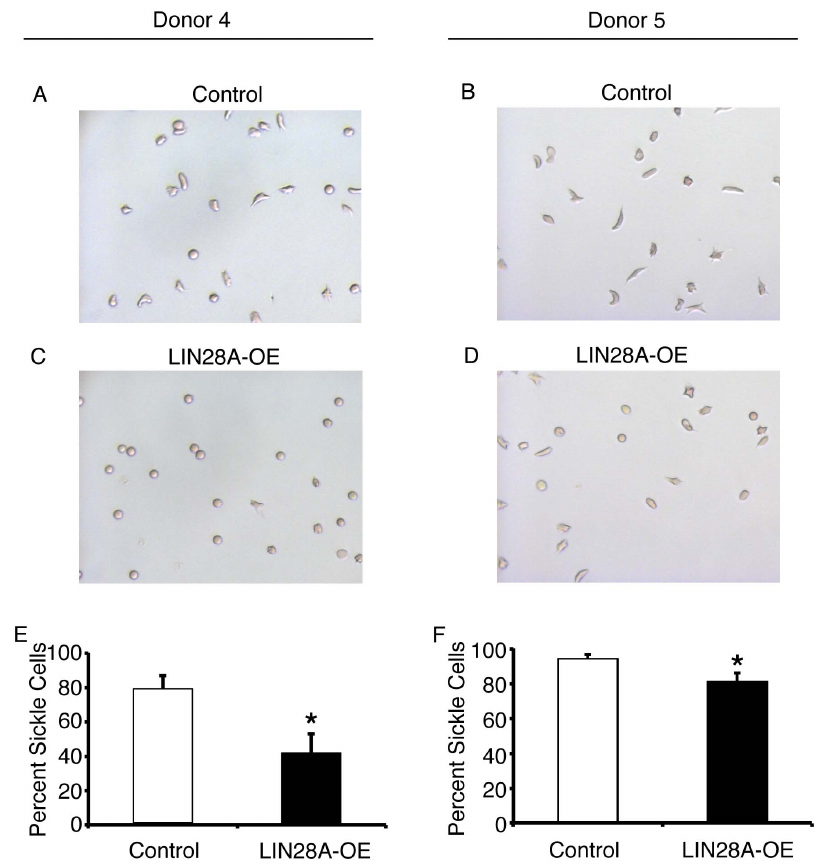
Figure 5. LIN28A over-expression ameliorates abnormal morphologies associated with sickle mature erythrocytes. Cell images are representative from two independent research subjects as follows: Donor 4 (A) control and (C) LIN28A -OE, and Donor 5 (B) control and (D) LIN28A - OE. Cells were scored according to round versus variable sickle morphologies (non-round). Average cell counts of variable sickle morphologies from Donor 4 (E) and Donor 5 (F) . Error bars denote 6 SD of 8 fields for each condition per donor. P values were calculated using Student’s t-test. Control: empty vector control; LIN28A -OE: LIN28A over-expression. *p , 0.05.